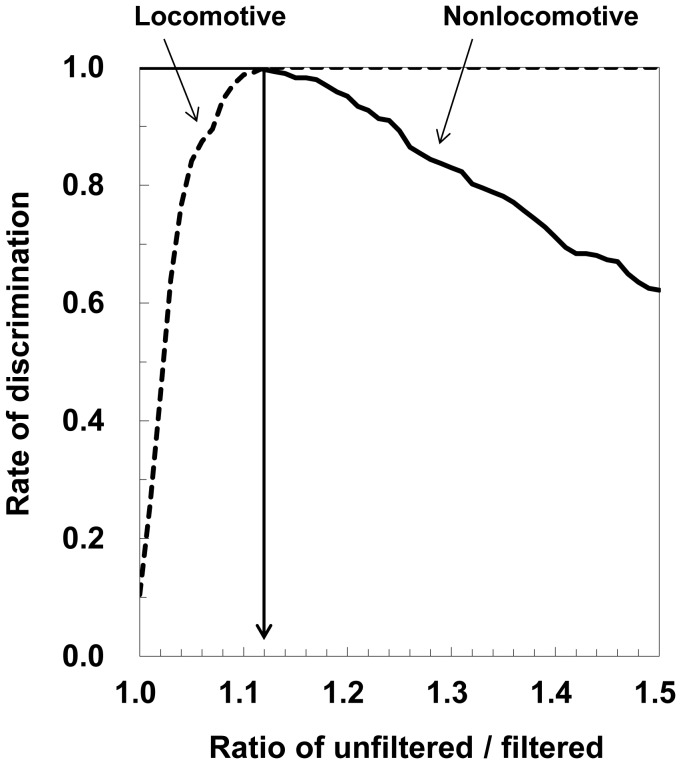
Probability of correctly detecting locomotive and nonlocomotive activities in the development group (n = 48).